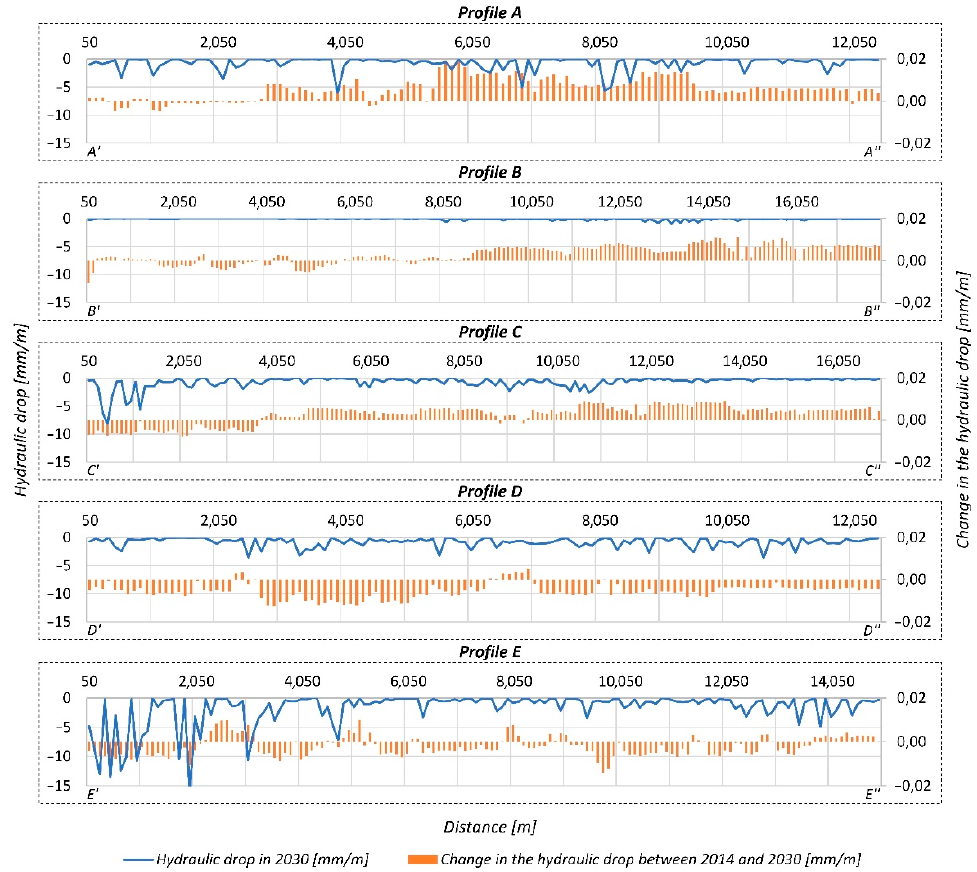
Figure 14. Hydraulic drop profiles for selected ( A – E ) watercourses in 2030 and changes in these drops between 2014 and 2030; see Figure 12 for profile location; A ′ -E ′ and A ″ -E ″ points mark the start and endpoints of selected profiles, respectively.